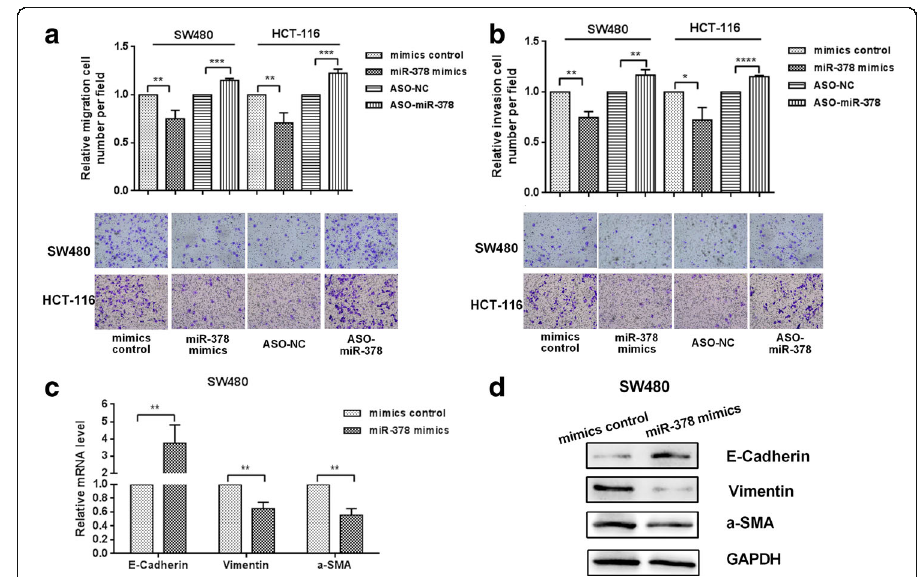
Fig. 3 The effect of miR-378 on the migration and invasion abilities of colon cancer cells. a , b The effect of miR-378 mimics on the migration ( a ) and invasion ( b ) of SW480 and HCT-116 cells determined using Transwell plates. c Quantitative RT-PCR was used to measure the mRNA levels of three EMT markers, e- Cadherin, vimentin and a-SMA, in miR-378 mimics transfected SW480 cells. d Western blot was used to measure the protein levels of these EMT makers in SW480 cells transfected with miR-378 mimics. * p < 0.05, ** p < 0.01, *** p < 0.001, **** p <